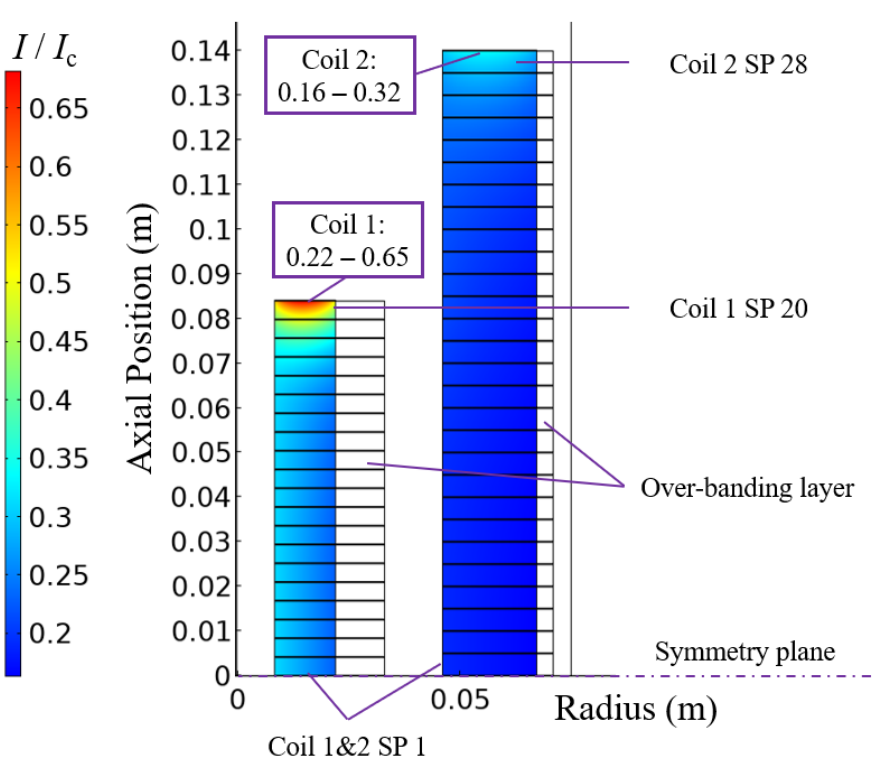
Figure 1. The distribution of I / I c in the HTS insert at I op = 244 A.